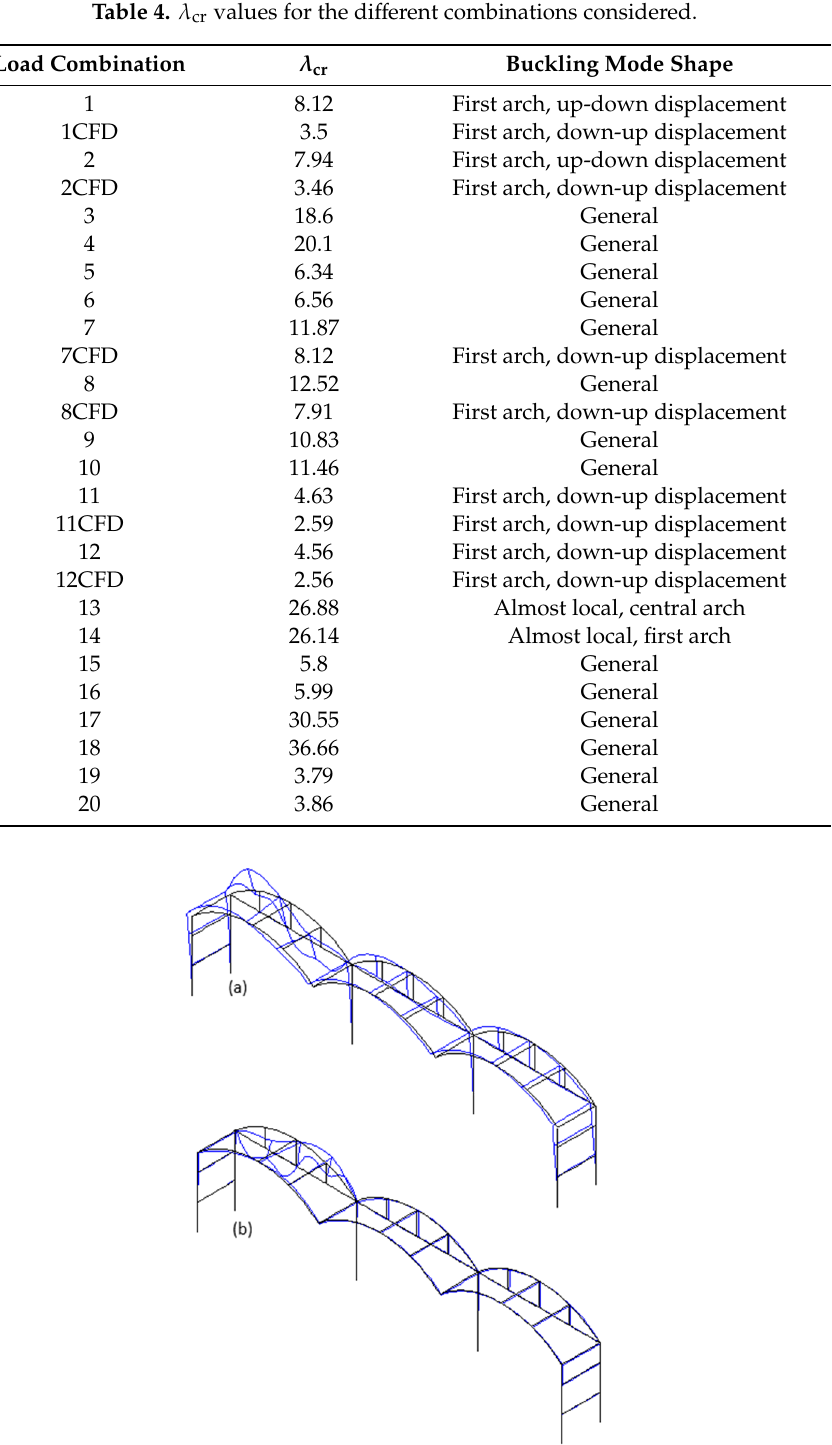
Figure 21. Buckling mode for ( a ) load combination 2 based on wind loads according to EN 13031-1 (2001) (first arch, up-down displacement type) and ( b ) load combination 2CFD based on wind loads calculated through CFD (first arch, down-up displacement type).